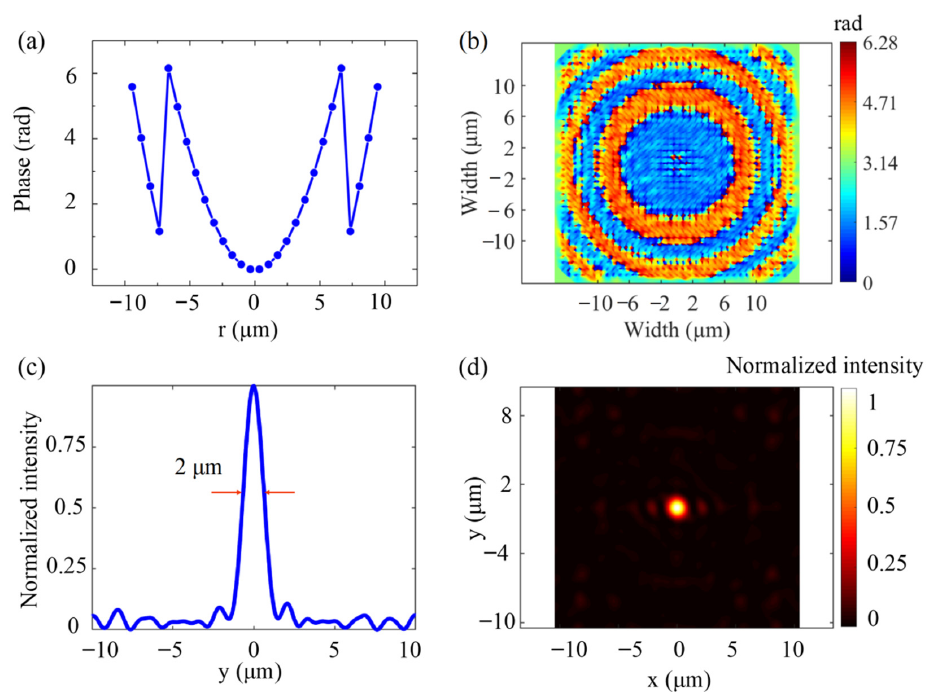
Figure A1. The realization of the metalens. ( a ) The hyperbolic phase distribution of metalens with sampling at the centre of each unit cell. ( b ) The output near-field phase distribution of metalens ( z = 19.9 μ m). ( c ) FWHM of foci (2 μ m). ( d ) Simulated intensity distributions of the foci at λ = 1.817 μ m.